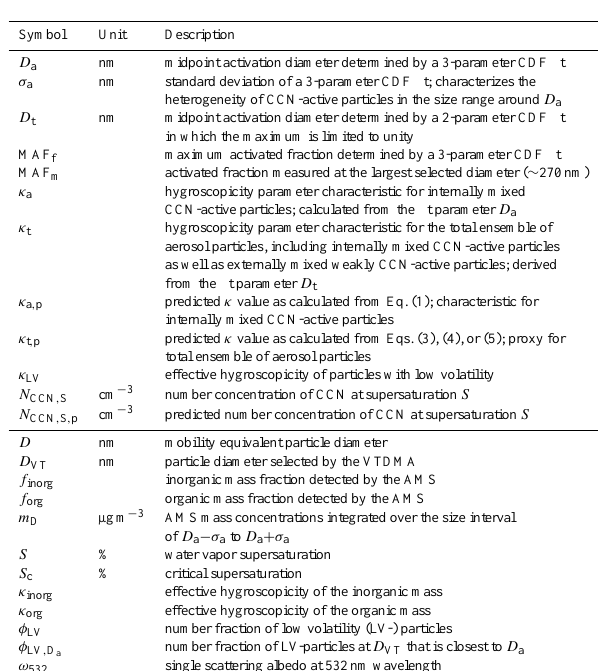
Table 1. List and short description of CCN parameters and other symbols used in this study. The first four variables are fit param- eters of a cumulative Gaussian distribution function (CDF) fit of the CCN efficiency spectrum (Eq. (1) of Rose et al., 2010a). The κ parameters are effective hygroscopicity parameters (Petters and Kreidenweis, 2007). Details about the definition and determination of all parameters can be found in Rose et al.